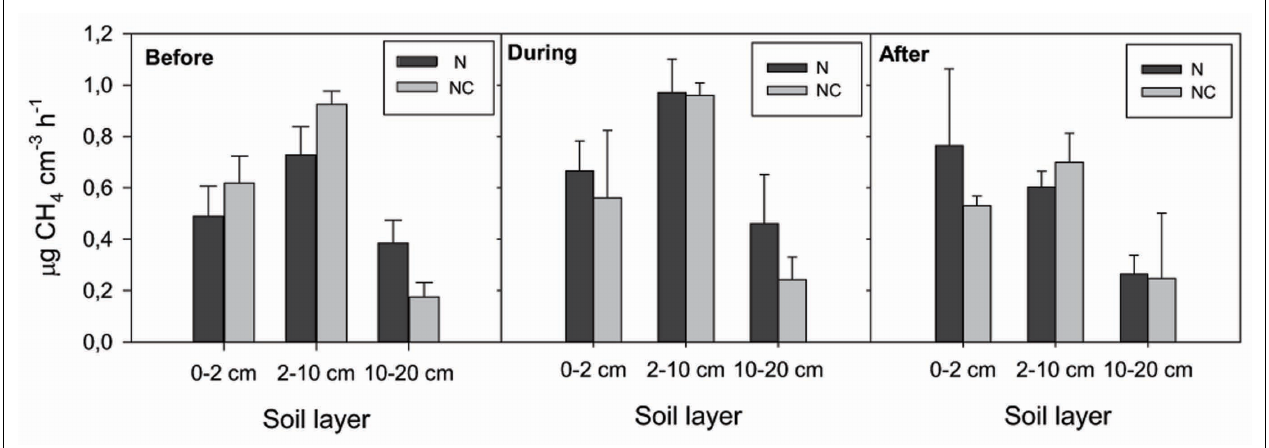
FIGURE 1 | Methane oxidation potential. N denotes nitrogen loading plots and NC control plots. Fixed effect of nitrogen load: F 0–2cmlayer = 0.105, P = 0.762; F 2–10cmlayer = 0.821, P = 0.416; F 10–20cmlayer = 2.035, P = 0.227.